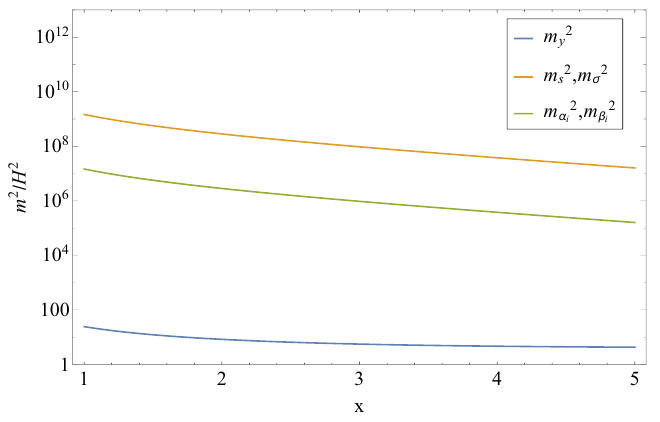
= 0 . 005 , B = 1 . All values are given in the 2